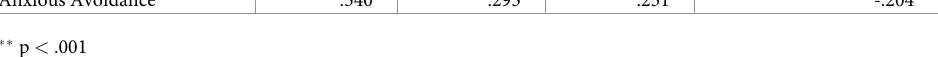
Table 5. Bivariate correlations between subscales of the DAAPGQ and theoretically related